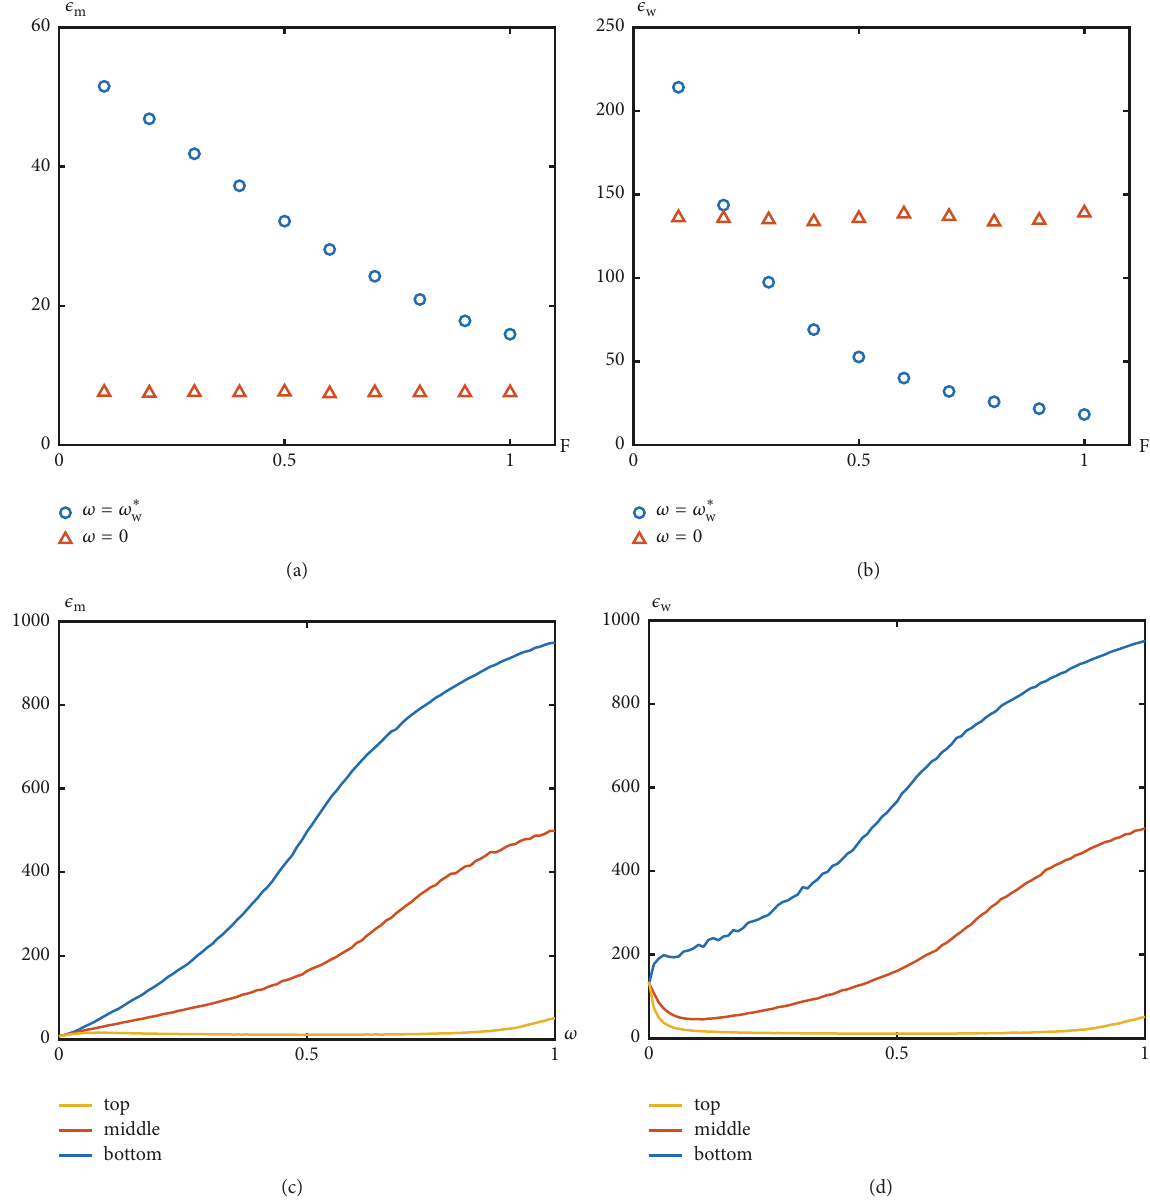
Figure 4: The average ‘energy’ of different popularity groups; the horizontal axis shows the different values of popularity. 𝑁 = 1000 ; the result is averaged over 100 realizations. (a) The average ‘energy’ of men at 𝜔 = 0 and 𝜔 = 𝜔 ∗ 𝑤 ; (b) the average ‘energy’ of women at 𝜔 = 0 and 𝜔 = 𝜔 ∗ 𝑤 ; (c) the average ‘energy’ of three representative popularity groups of men, bottom(0,0.1), middle(0.45,0.55), and top(0.9,1), versus (d) the average ‘energy’ of three representative popularity groups of women, bottom(0,0.1), middle(0.45,0.55), and top(0.9,1), versus 𝜔 . Note that when 𝜔 = 0 (triangles) the average ‘energy’ of men or women stays the same as the value shown in Figure 2(a); the small deviations are the random fluctuations which are irrelevant to the